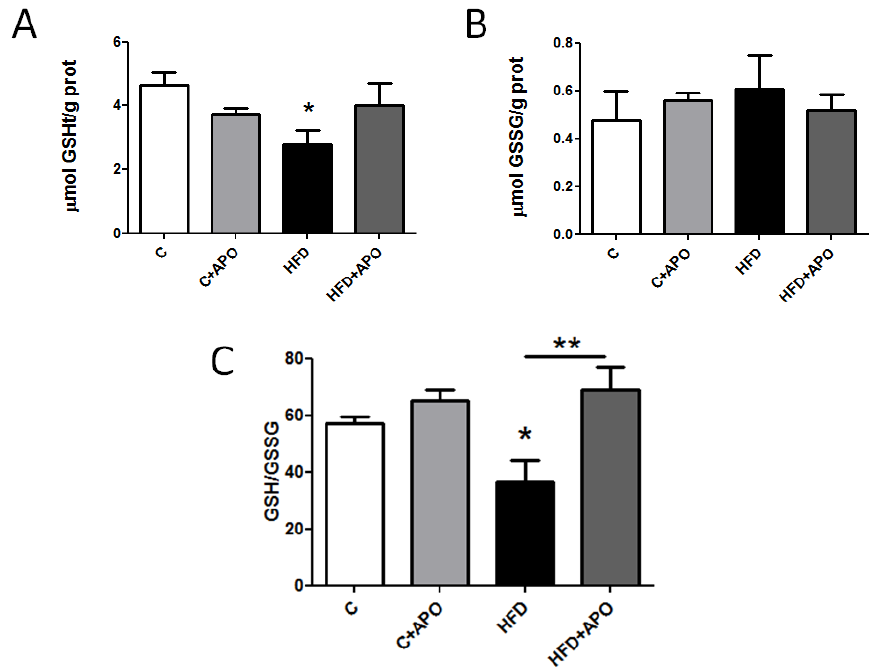
Figure 3. Apocynin effects on glutathione concentration. Control and insulin resistance mice were used after 14 h fasting. Total (tGSH) ( A ) and oxidized (GSSG) ( B ) glutathione concentrations were determined in tibialis anterior (TA) skeletal muscles through an enzymatic recycling method (Oxis Research). GSH/GSSG ratio is shown ( C ). All measurements were normalized to protein content (g). APO: mice treated with apocynin during eight weeks ( n = 6, ANOVA, Newman-Keuls, * p < 0.06). GSSG ( n = 6, ANOVA, Newman-Keuls, * p <